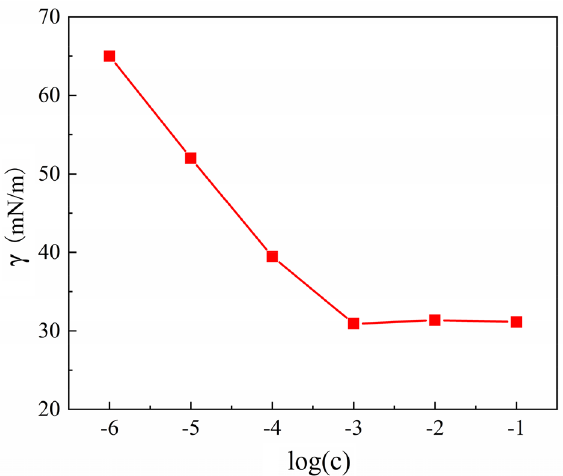
Figure 2. The relationship between the surface tension (γ mN/m) and concentration (c